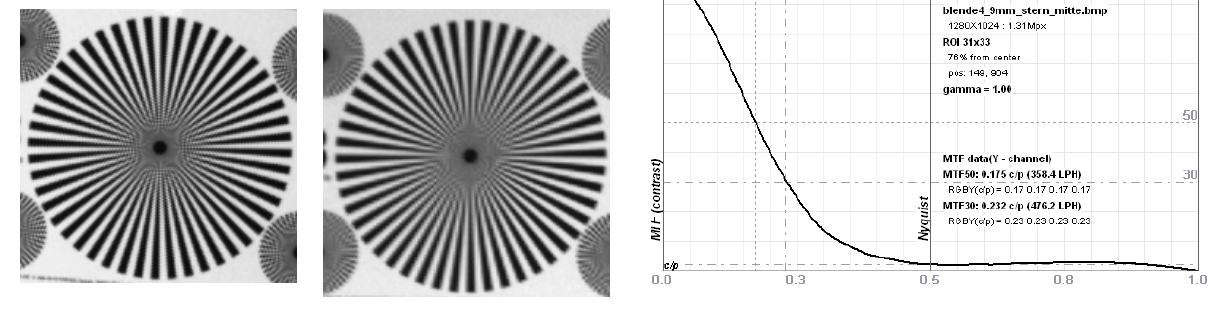
Figure 11: MTF of Crevis a the image corner (f-stop 4,0) Figure 8: Siemens star image Figure 9: Siemens star upper center left corner Fine periodic samples define only a small part of the motif properties, which can be detected by human eyes. More important are edges and lines between two areas with different brightness and color. Most important are edges, which separate two regions of different brightness or color. The Line Spread Function (LSF) provides information how (sharp) a black to white edge is represented in the digital image. The transition between black and white is 2.22 pixels wide at the image center, Figure 12. Due to the fact that no integrated edge sharpening inside the camera is done, no negative values occur before and after the edge.